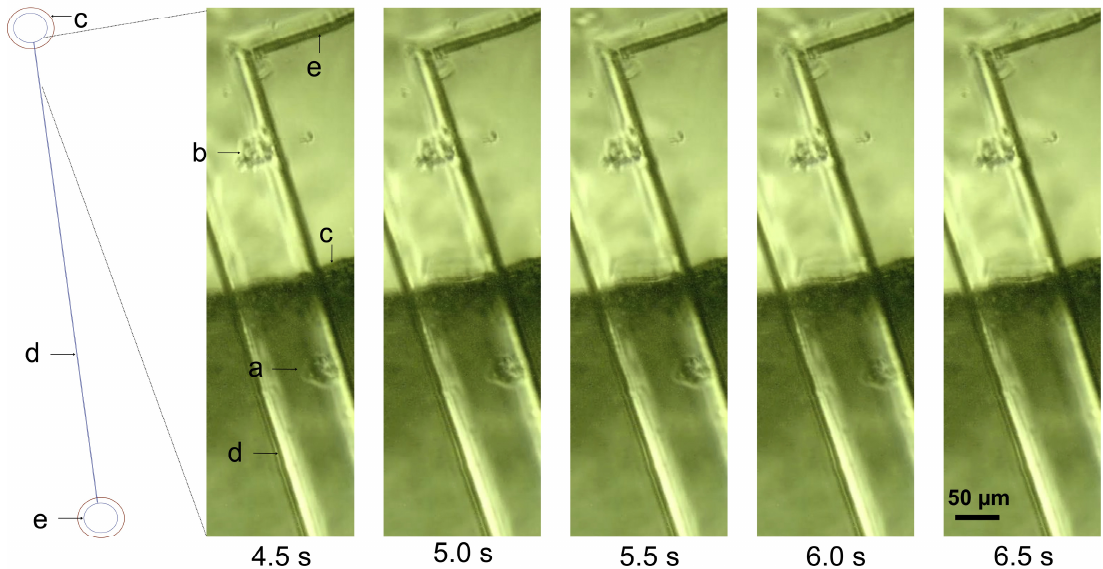
Figure 6. Temporal sequence of images of electrical lysis of a single sample cell under a high electric field inside a microchannel captured using an optical microscope. Here, ( a ) is a sample cell inside the microchannel, ( b ) is a cell inside the reservoir, ( c ) is the boundary of the reservoir on the top glass slide, ( d ) is the edge of the microchannel and ( e ) is the boundary of the etching on the bottom glass slide. Eight-hundred volts are applied to the microchannel of 9 mm length. The cell is observed to disappear between 6 and 6.5